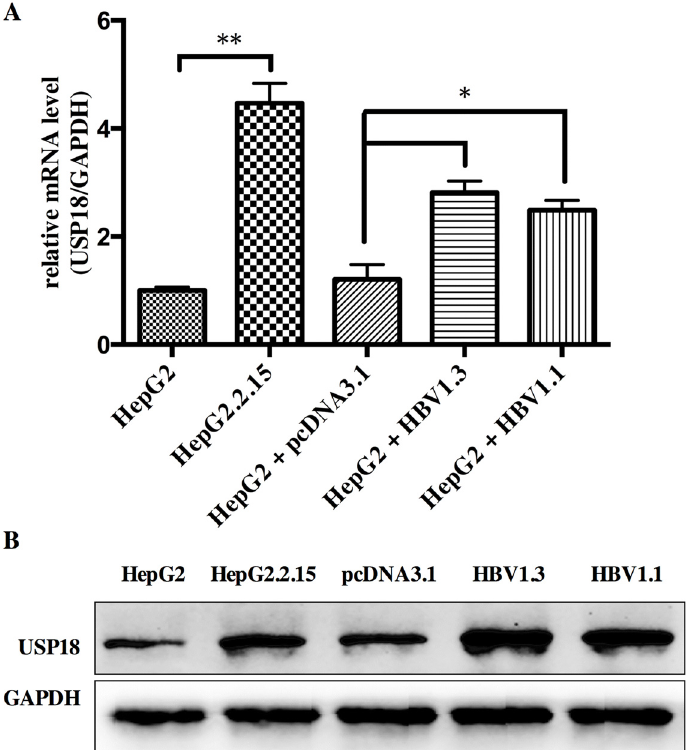
Fig 1. The level of USP18 was up regulated in Hepg2.2.15 and Hepg2 cells transfected with HBV1.3 or HBV1.1 expression vectors compared to that of Hepg2 cells. (A) The mRNA level of USP18 in Hepg2, Hepg2.2.15 and Hepg2 cells transfected with HBV1.3 or HBV1.1 expression vectors. * P < 0.05; ** P < 0.01 vs. control. (B) Western blot analysis of USP18 protein level in Hepg2, Hepg2.2.15 and Hepg2 cells transfected with HBV1.3 or HBV1.1 expression